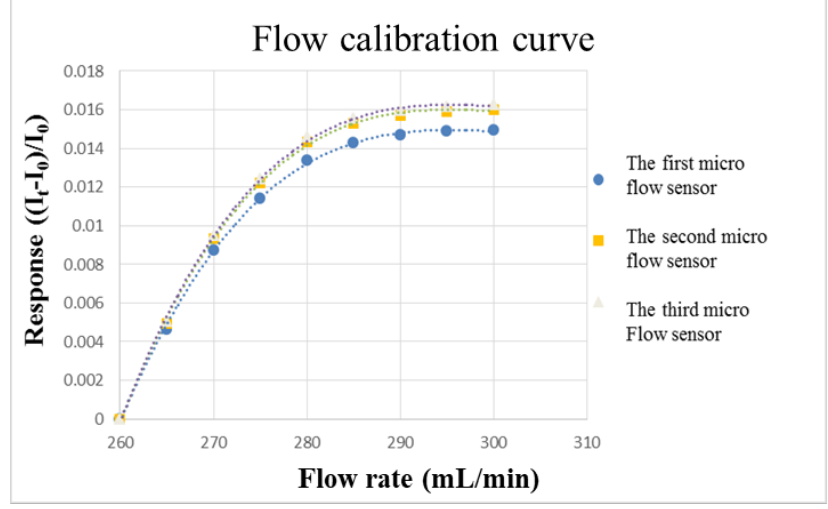
Figure 11. Flow calibration curve.